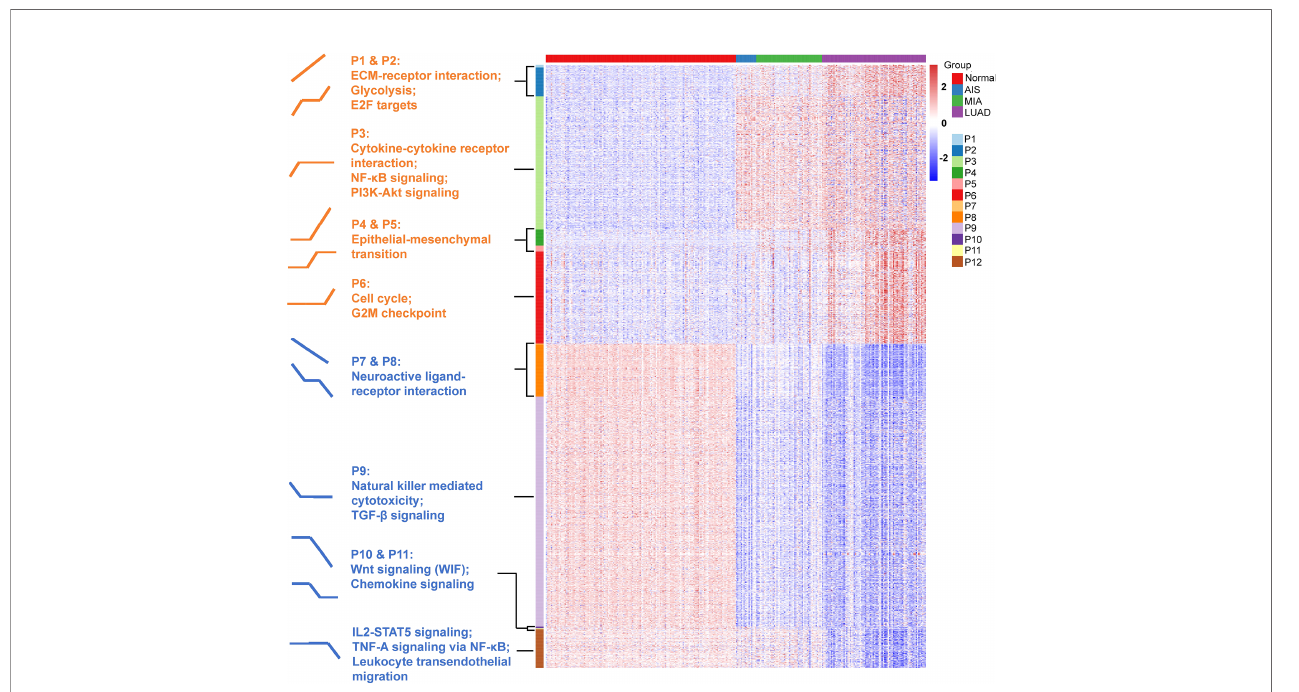
FIGURE 4 | Identi fi cation of 12 expression patterns and prediction of immune cell in fi ltration. Pattern 1 (nine genes): increase from normal to AIS, from AIS to MIA and from MIA to LUAD; pattern 2 (97 genes): increase from normal to AIS and from MIA to LUAD, no change from AIS to MIA; pattern 3 (446 genes): increase from normal to AIS alone; pattern 4 (54 genes): no change from normal to AIS, increase from AIS to MIA and from MIA to LUAD; pattern 5 (20 genes): increase from AIS to MIA alone; pattern 6 (309 genes): increase from MIA to LUAD alone; pattern 7 (three genes): decrease from normal to AIS, from AIS to MIA and from MIA to LUAD; pattern 8 (175 genes): decrease from normal to AIS and from MIA to LUAD, no change from AIS to MIA; pattern 9 (771 genes): decrease from normal to AIS alone; pattern 10 (six genes): no change from normal to AIS, decrease from AIS to MIA and from MIA to LUAD; pattern 11 (three genes): decrease from AIS to MIA alone; pattern 12 (130 genes): decrease from MIA to LUAD alone. Gene set enrichment analysis (GSEA) was performed to assess the functional signi fi cance for those